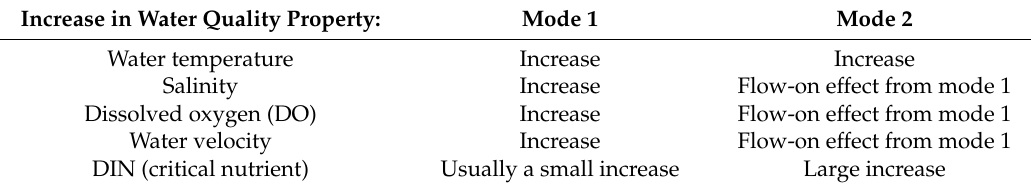
Table 1. Effect of main influences on CuNi corrosion mass loss. DIN: Dissolved inorganic nitrogen Increase in Water Quality